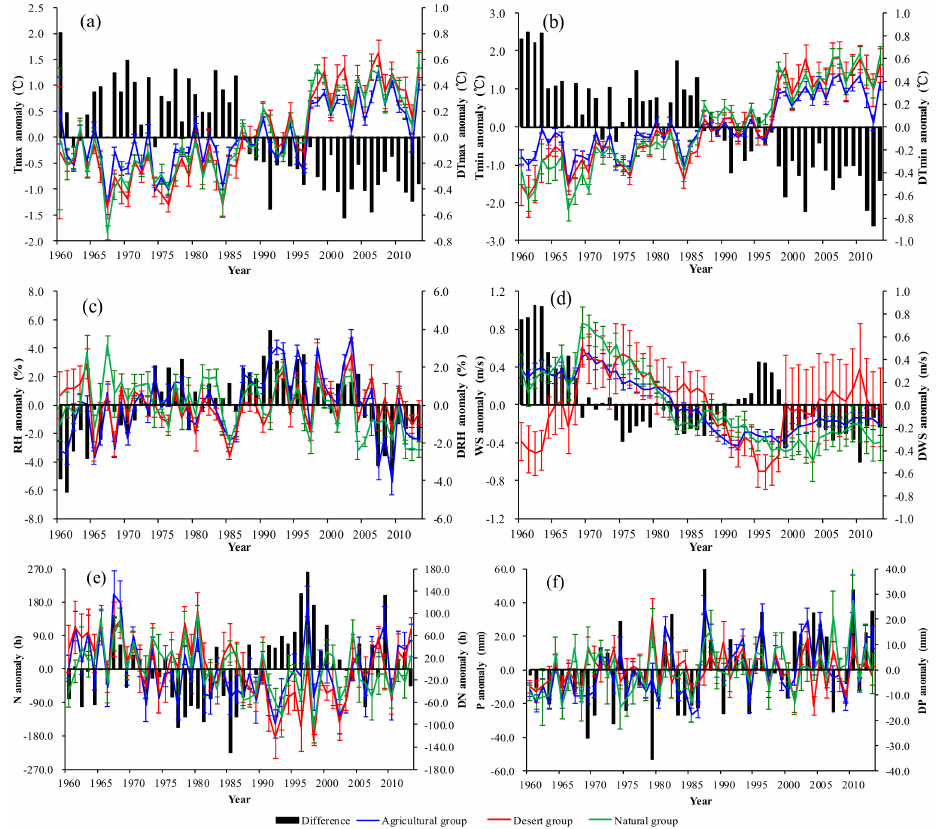
Figure 8. Time series of station-average annual meteorological factor anomalies for the different station groups, 1960–2013. The error bar indicates standard deviation of mean meteorological factor anomalies. The difference indicates the meteorological factor anomaly differences between the agricultural group and the desert group, ( a ) Maximum air temperature; ( b ) Minimum air temperature; ( c ) Relative humidity; ( d ) Wind speed; ( e ) Sunshine hours; ( f )